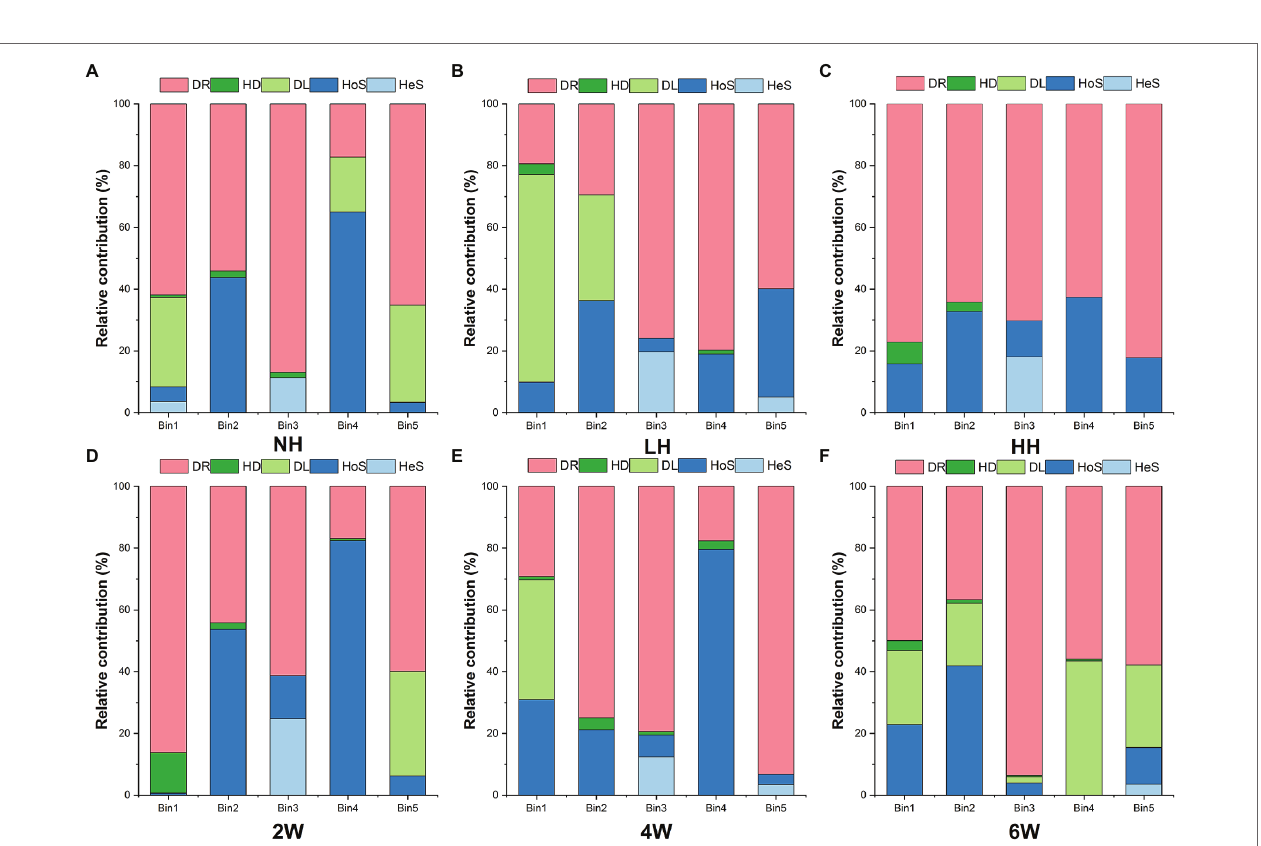
FIGURE 4 | Relative abundance and relative contribution of each bin. Only the five most abundant bins are shown in this figure. Source data can be found in Supplementary Table S3 .